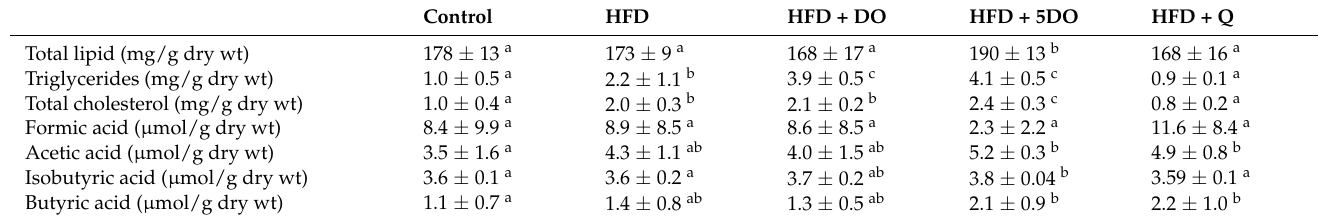
Table 6. Effects of dried onion powder and quercetin on fecal lipid profiles in Sprague Dawley rats exposed to HFD 1